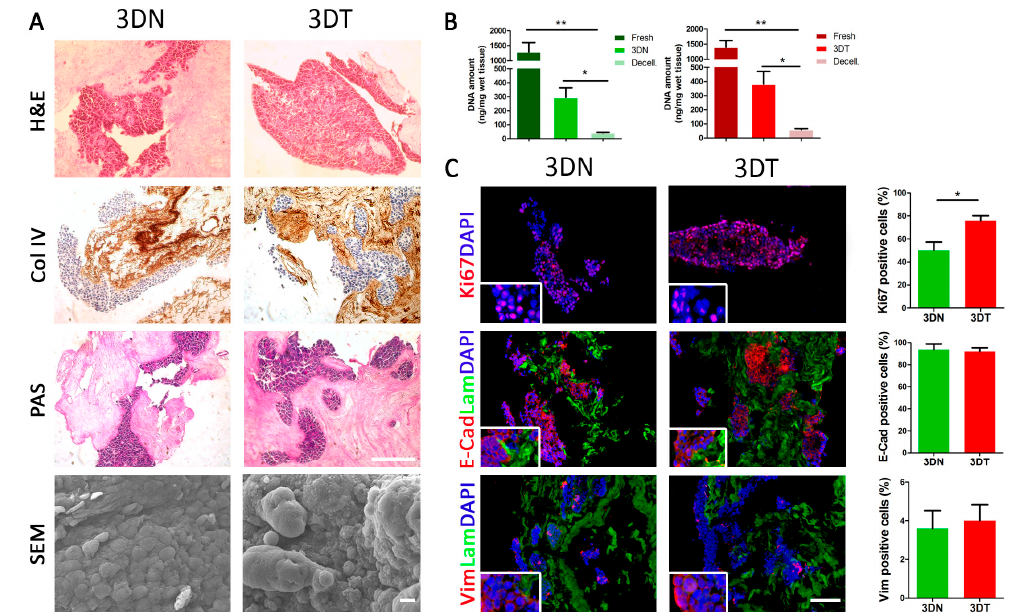
Figure 1. Characterization of matched 3DN and 3DT HT29-recellularized samples. (A) histological characterization of sections stained with hematoxylin and eosin (H&E), collagen IV staining (Col IV), and periodic acid-Shiff (PAS) (scale bar = 200 µm). Scanning electron microscopy (SEM) analysis performed on 3DN and 3DT (Scale bar = 10 µm). (B) DNA amount quantification in fresh samples, after decellularization and 5 days of culture after seeding of HT29 cells, in both 3DN and 3DT. (C) IF staining in 3DT and 3DN and relative quantifications: Ki67, as proliferation marker; E-cadherin, as epithelial marker; vimentin, as mesenchymal marker; laminin to highlight basement membrane; DAPI to counterstain the nuclei (scale bar = 100 µm) (* p -value < 0.05; ** p -value < 0.01).